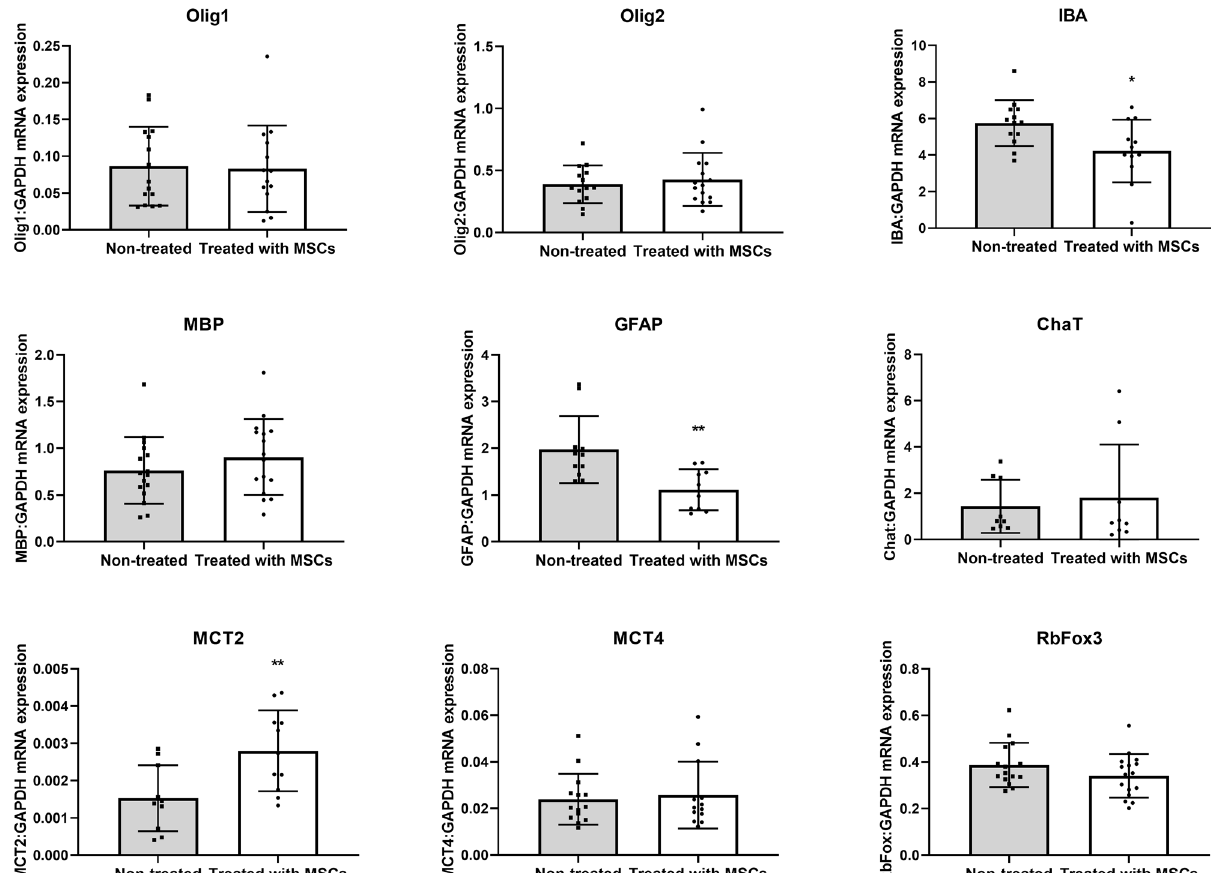
Figure 4. Real-time PCR analysis . Effect of canine MSCs transplantation on Olig1, Olig2, IBA, MBP, GFAP, Chat, MCT2, MCT4 and RBFox3 mRNA expression in the brains of DM dogs. Data are expressed as mean with standard deviation (SD) and differences were considered as statistically significant at the 95% confidence level (* P < 0.05, ** P <